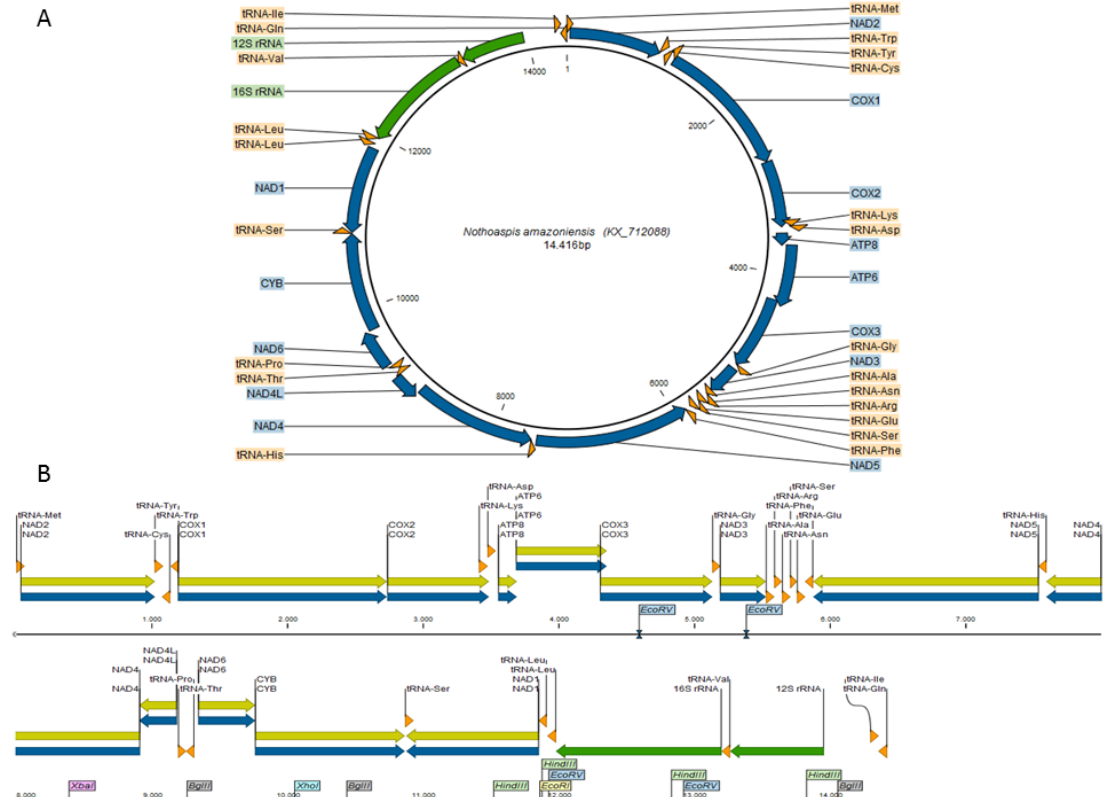
Figure 1. Mitochondrial genome map of Nothoaspis amazoniensis . ( A ) Circular representation; ( B ) linear representation. Thirty-seven genes (blue) and their respective CDS (yellow), two rRNA genes (green), and 22 tRNA genes (orange) are highlighted. The restriction enzyme sites are highlighted in the linear representation. The control region is located between the 12S rRNA and tRNA-IIe genes.